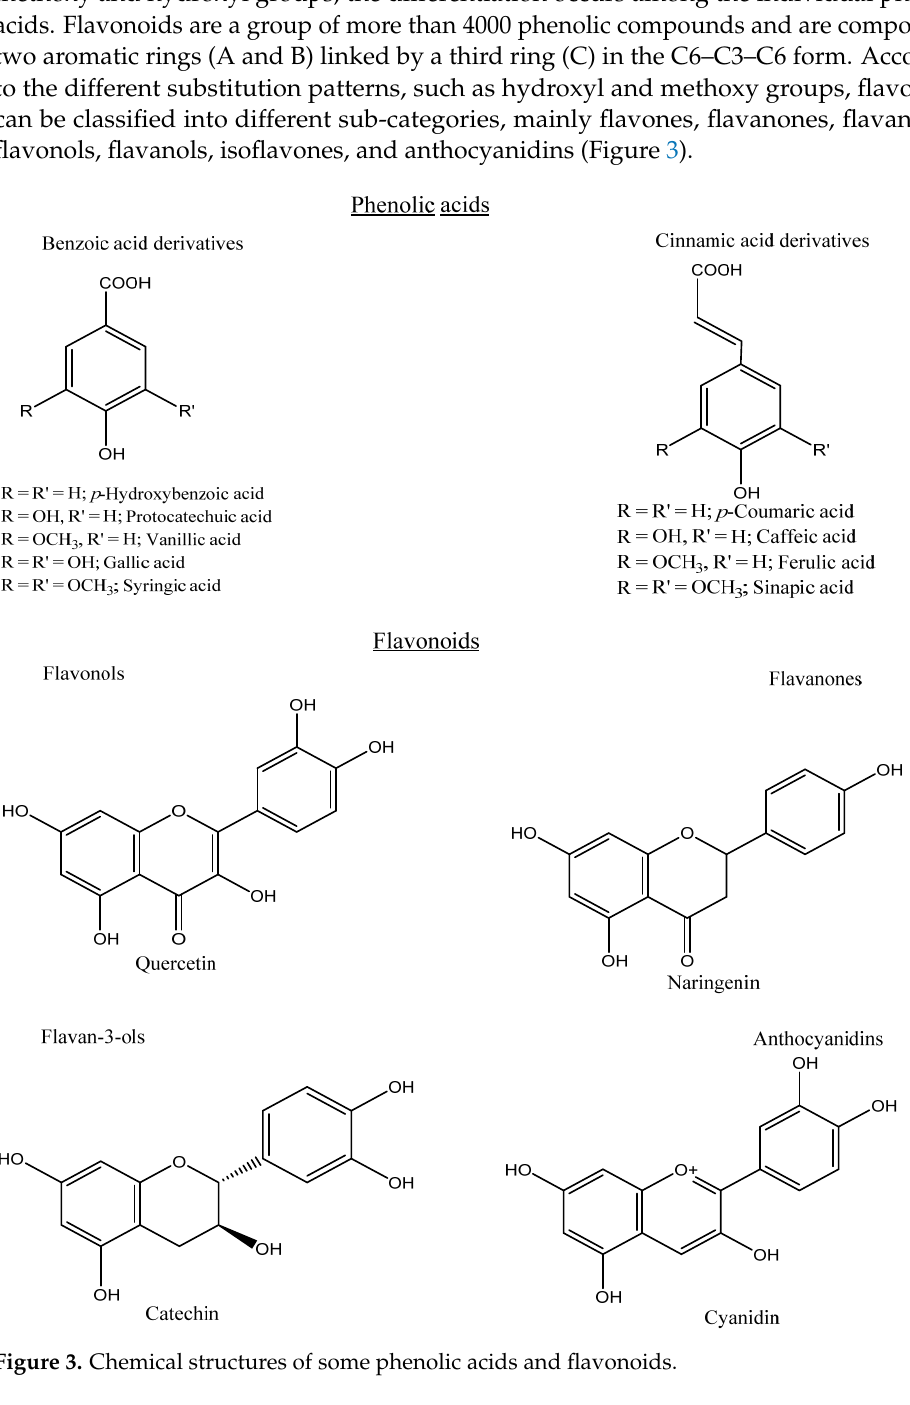
Food Matrix Based on the distribution in nature and location in plants, phenolic compounds either occur in free or bound (soluble and insoluble) forms. Generally, free phenolics are distributed within the plant cell vacuole, do not bind physically and chemically with other molecules, and can be extracted using organic or polar solvents. Soluble ‐ bound, including soluble ‐ glycosylated and soluble ‐ esterified ‐ bound, are covalently bound or esterified to sugars and low ‐ molecular ‐ weight macromolecules. Soluble ‐ bound phenolics are attached to one or more sugar units via carbon–carbon linkages (C ‐ glycosides) or a hydroxyl group (O ‐ glycosides). For instance, hydroxyl groups of cell wall substances can form ester bonds with the carboxyl group of phenolic acids (e.g., cinnamic and benzoic acids) and can also create ether bonds with the hydroxyl groups of phenolic compounds. In contrast, most